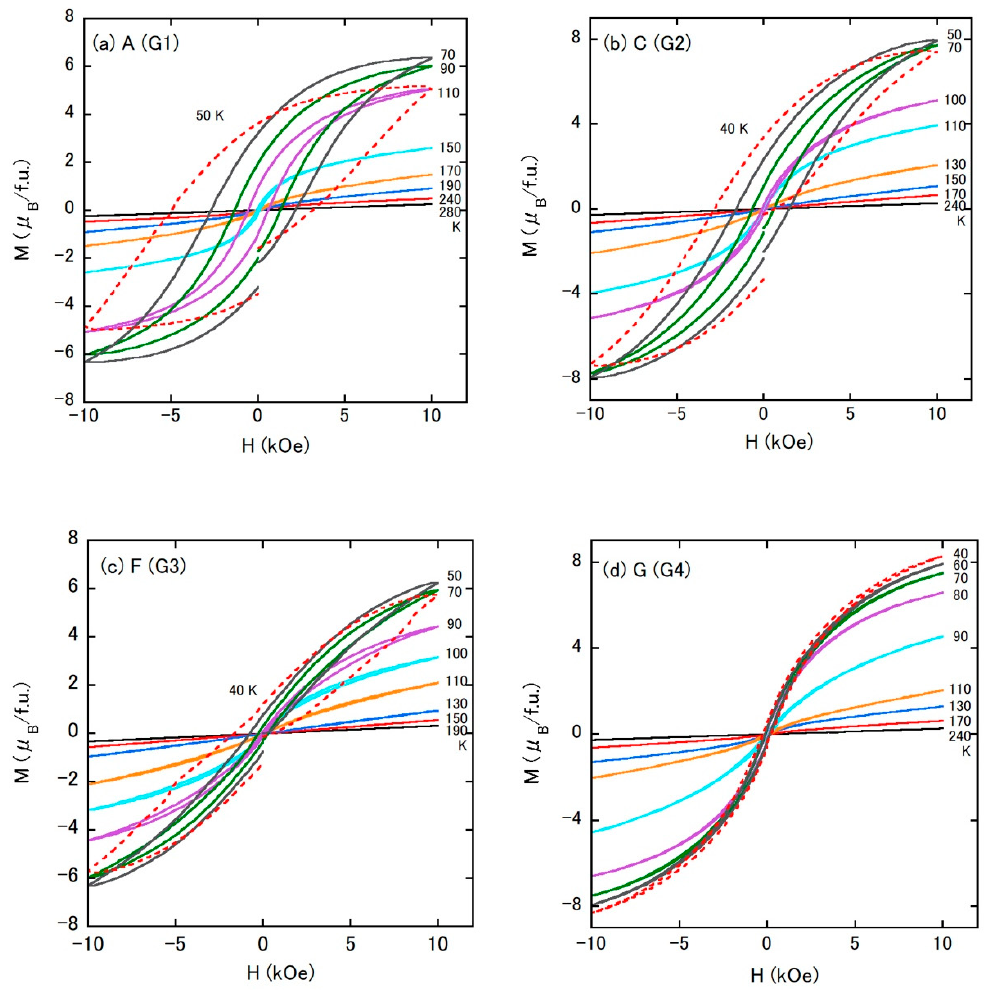
Figure 8. M - H curves measured at several temperatures as denoted in the figures for samples ( a ) A, ( b ) C, ( c ) F, and ( d ) G,